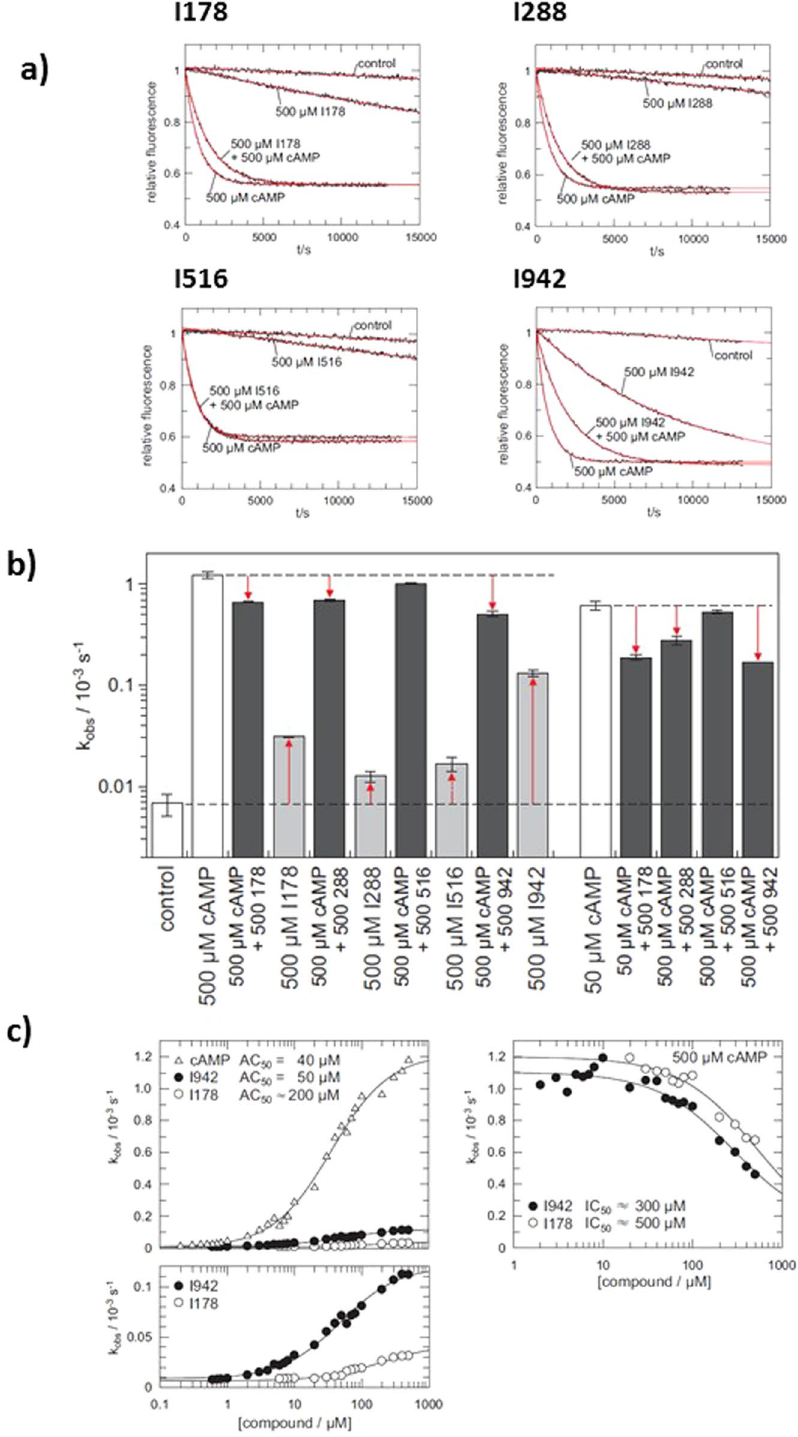
Figure 4. GEF activity of EPAC1. ( a ) Time trace of the exchange reaction with 500 μ M cAMP either 500 μ M I178, I288, I516 or I942 where indicated. The data are fitted as single exponential decay with off-set (red lines) to obtain the rate constants k obs , as shown in ( b ). Rate constants from exchange reactions with either 500 μ M or 50 μ M cAMP, the presence or absence of 500 μ M I178, I288, I516 or I942, as indicated, are presented as a bar graph (n = 4). ( c ) Exchange activity induced by cAMP, I942 or I178. The dependency of k obs on the concentration of cAMP (open triangles), I942 (closed circles) or I178 (open circles) is plotted on the left. The lower panel shows a magnification of the I942 and I178 induced activity. Inhibition of cAMP induced exchange activity by I942 and I178 is shown on the right. k obs were determined in the presence of 500 μ M cAMP and various concentrations of I942 or